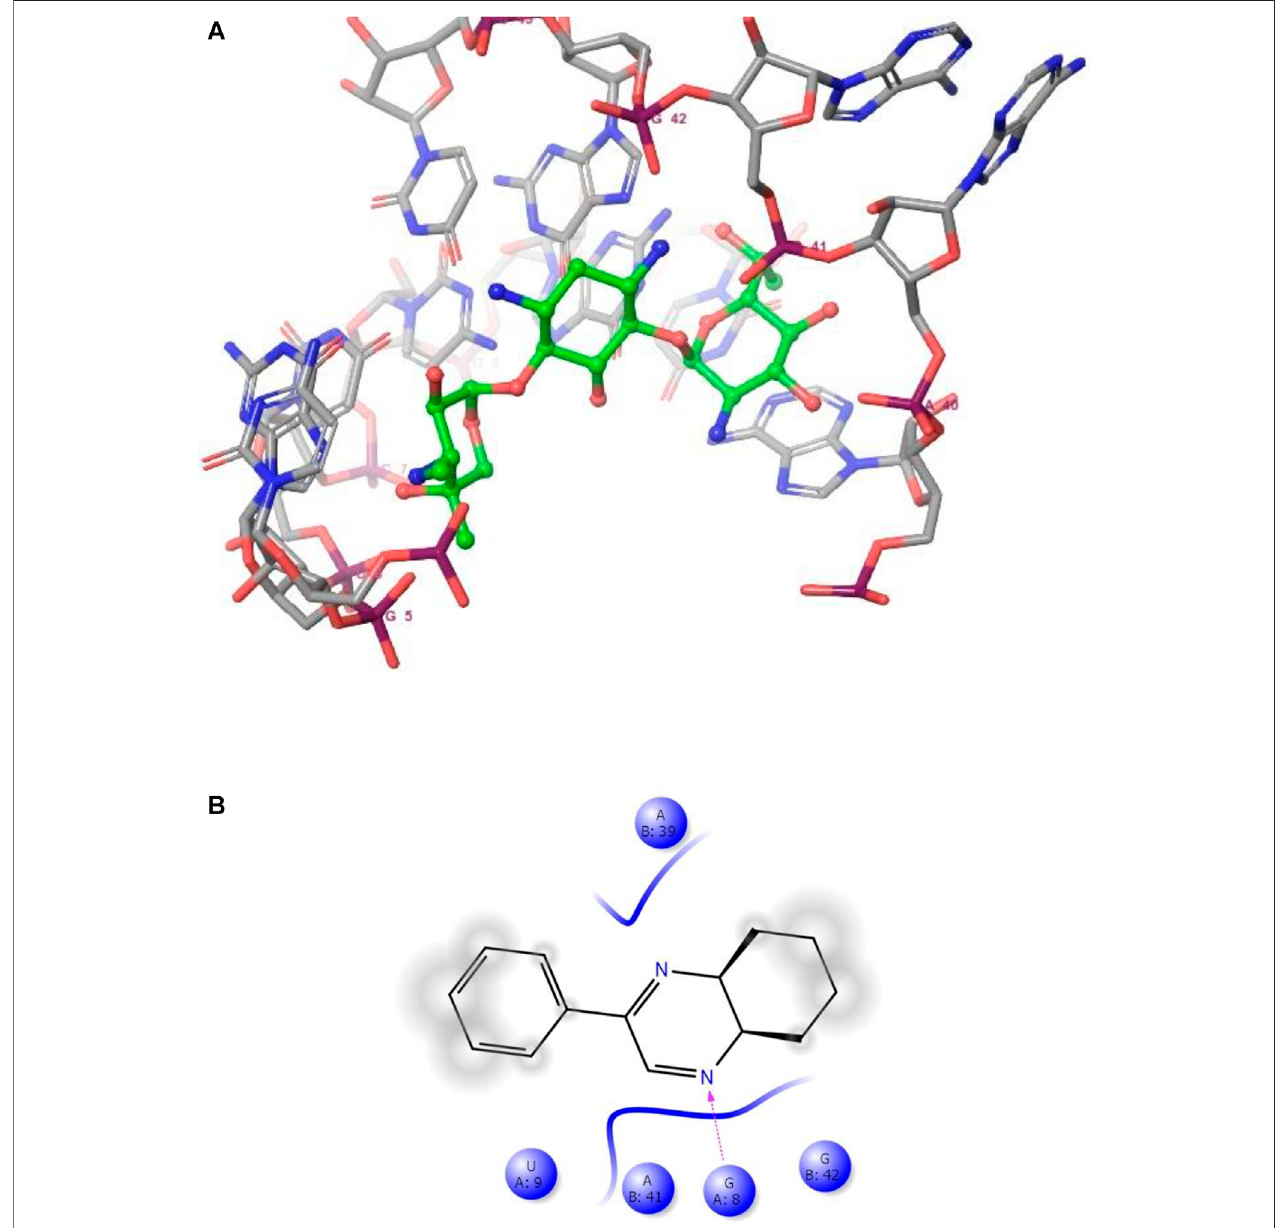
FIGURE 4 | (A) The binding mode of the interactions between 1 with Leishmanial rRNA A-site (PDB ID: 4K32). (B) Results of the validation of 1 inside the Leishmanial rRNA A-site active